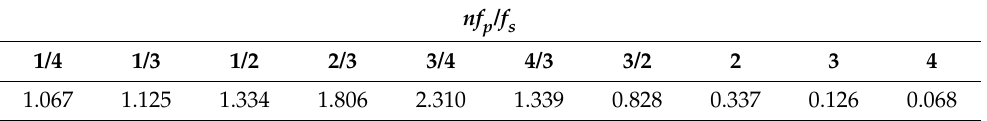
Table 6. The off-resonance reduction factors C λ ( n , ξ ) ( nf p / f s (cid:54) = 1).